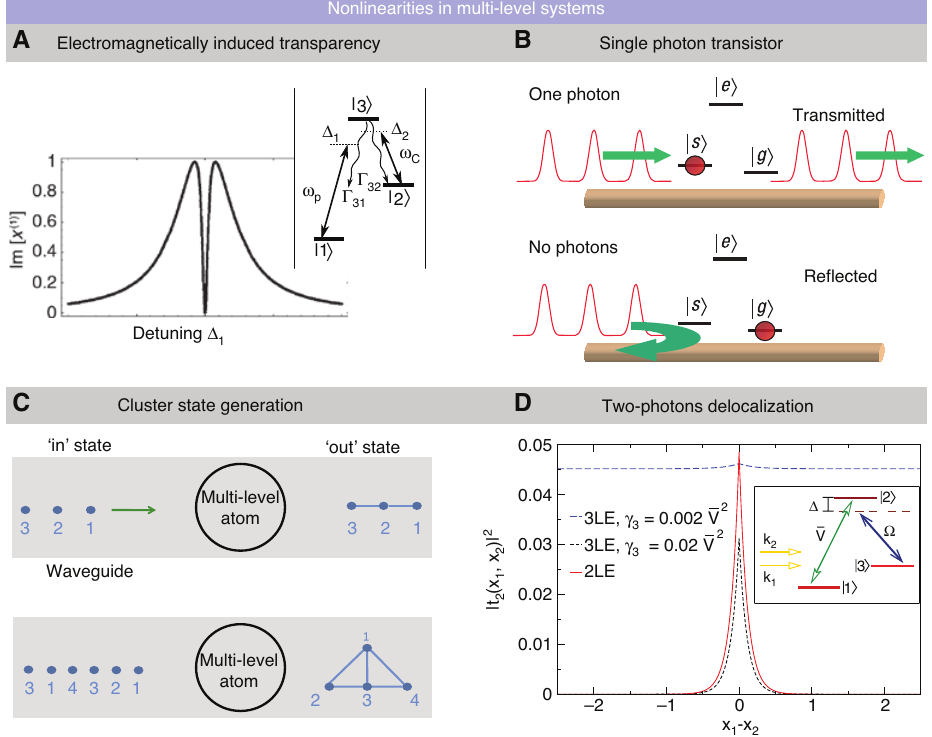
and control field of frequency ω Figure 6: (A) Generic Ʌ-type scheme (left) and spectrum (right) for EIT where a probe field of frequency ω P C interact with a quantum emitter. In the presence of the control beam transition |1〉 → | 3〉 is inaccessible and hence the absorption spectrum sharply falls to 0 on resonance. Adapted from [104]. (B) Schematic diagram of a single-photon transistor based on a three-level emitter. The storage of a gate pulse containing zero or one photon conditionally spin-flips the state of the emitter, depending on the photon number. A subsequent incident signal field is then either transmitted or reflected depending on the state of the emitter. Adapted from [76]. (C) Example of photonic cluster state generation by sequential scattering from a multilevel emitter. In the top panel, three un-entangled photons sequentially scatter from an emitter, creating a three-photon matrix product state. In the bottom panel, four photons scatter from the emitter. After the fourth photon scatters, the first and third photons are re-scattered, creating a two-dimensional projected entangled pair state. Adapted from [105]. (D) Calculated two-photon spatial probability distribution after the scattering of two photons off a driven three- ≈ 0), the two-photon state is delocalized. As γ level emitter (energy-level scheme shown in inset). In the low-loss limit (i.e. γ increases, the 3 3 behavior of the driven system begins to resemble that of a two-level emitter. Adapted from